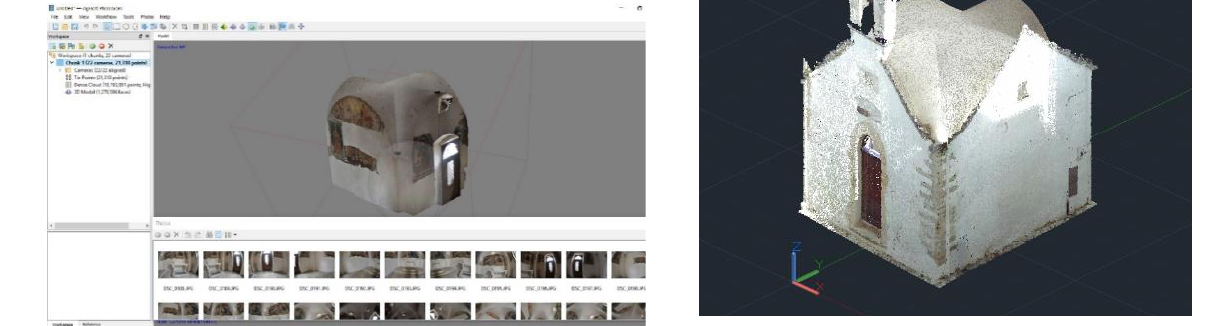
Figure 5. 3D model after